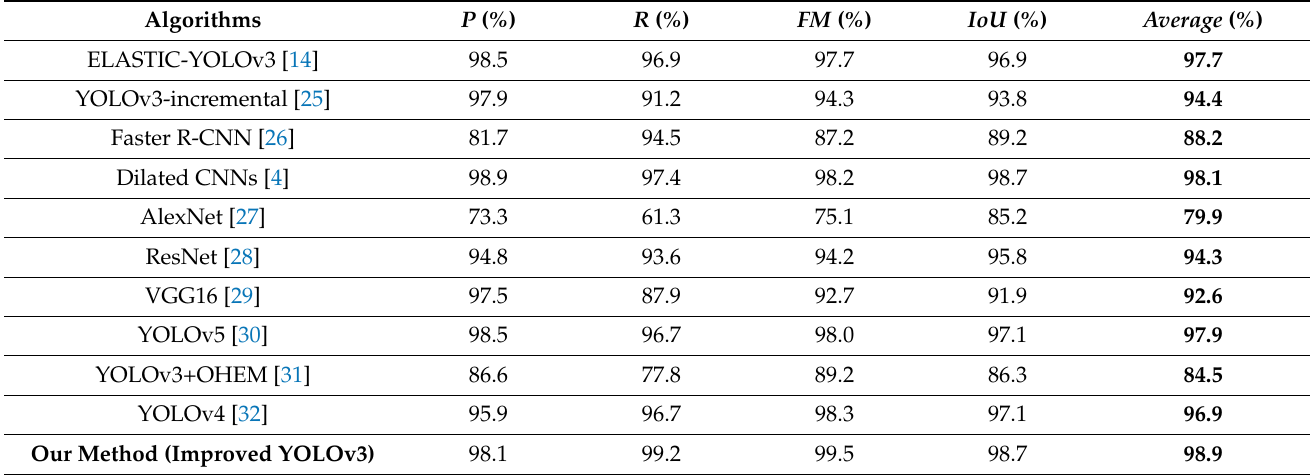
Table 7. Quantitative results of fire